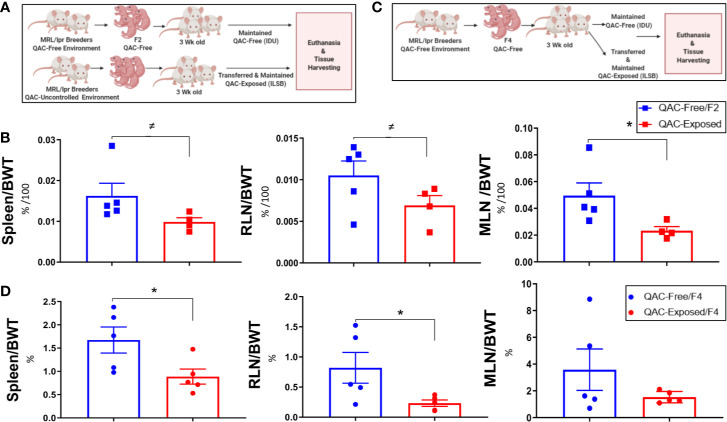
Reduced lupus-associated splenomegaly with ambient exposure to QACs. (A) Study design of the 1st experimental setting. See text for details. (B) Weight of lymphoid organs shown as ratios to the body weight at 16 weeks of age. RLN, renal lymph node. MLN, mesenteric lymph node. (C) Study design of the 2nd experimental setting. (D) Weight of lymphoid organs shown as ratios to the body weight at 12 weeks of age. Data are represented as mean ± SEM. ≠P < 0.10, *P < 0.05.